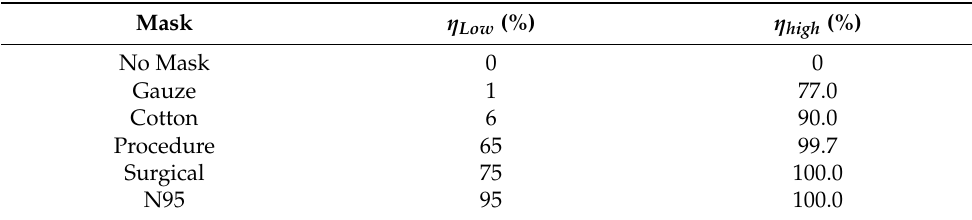
Table 1. The highest and lowest efficiency of face mask ( η high and η Low ,